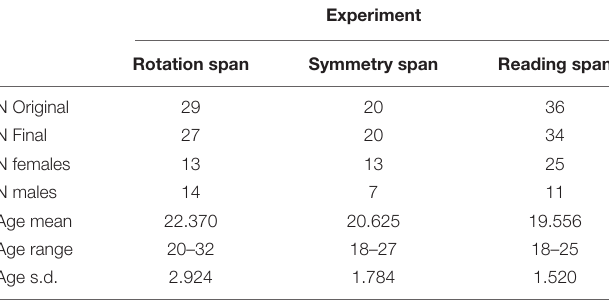
TABLE 5 | Demographic information for Experiment Series